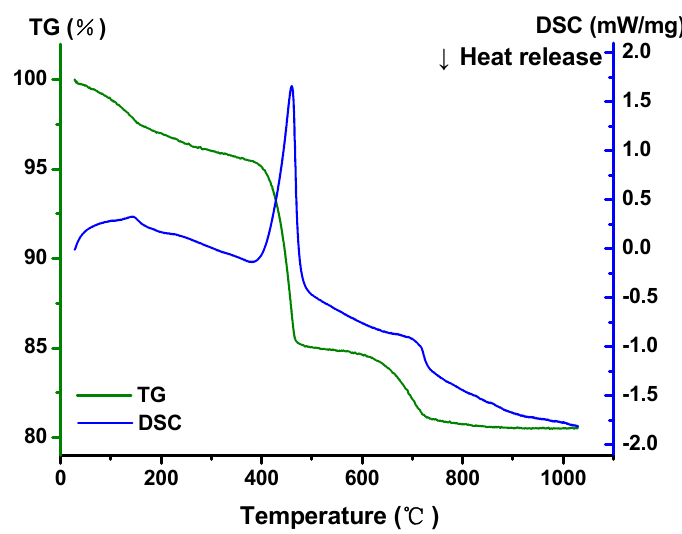
Figure 12. TG-DSC-DTA data of Y 2 SmSbO 7 .